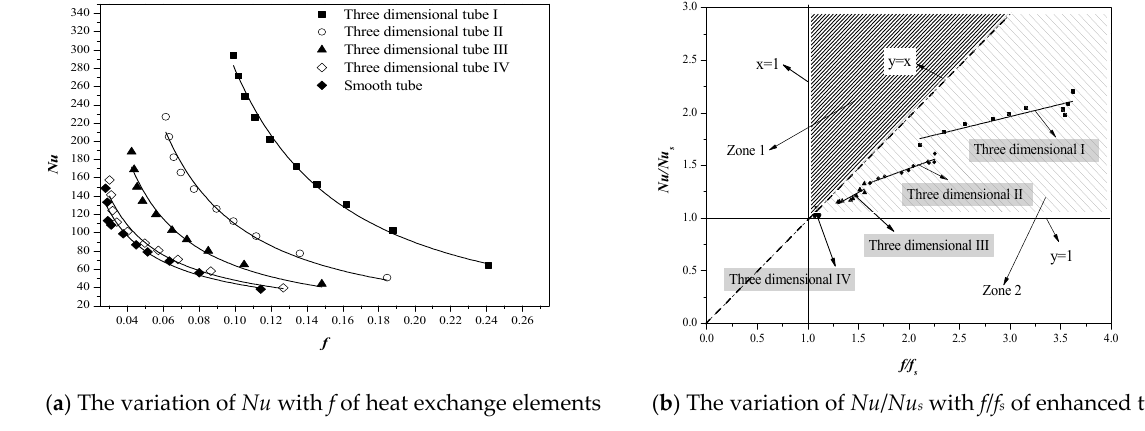
Figure 6. Curves of Nu and Nu / Nu s outside three-dimensional tube changing with f and f / f s .